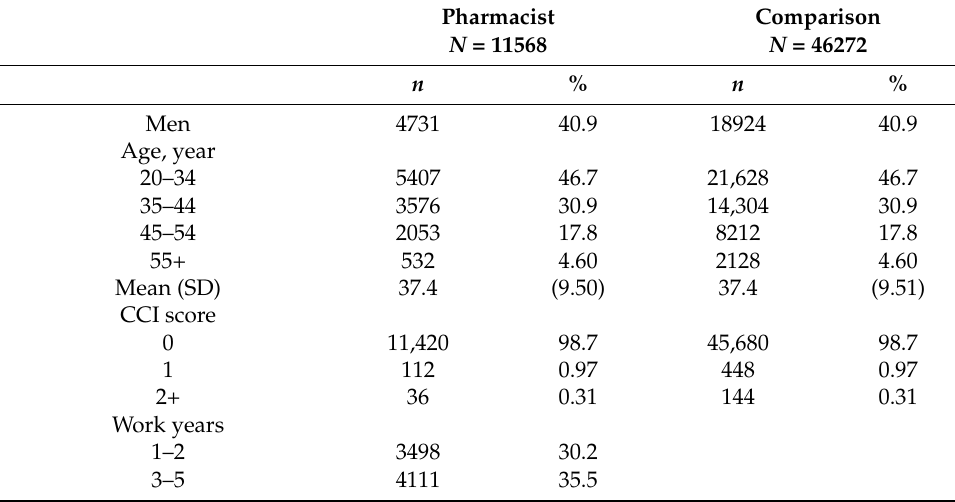
Table 1. Distribution of age, gender and CCI score between pharmacists and